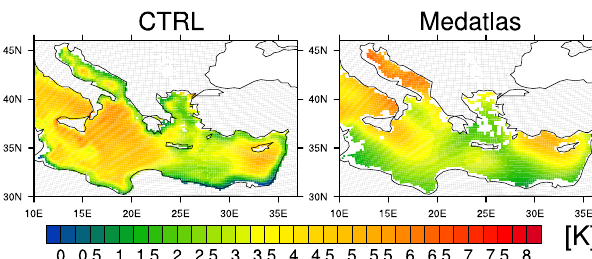
Fig. 12. Summer (JAS) temperature difference between 6 and 27m of depth, for CTRL and MEDATLAS